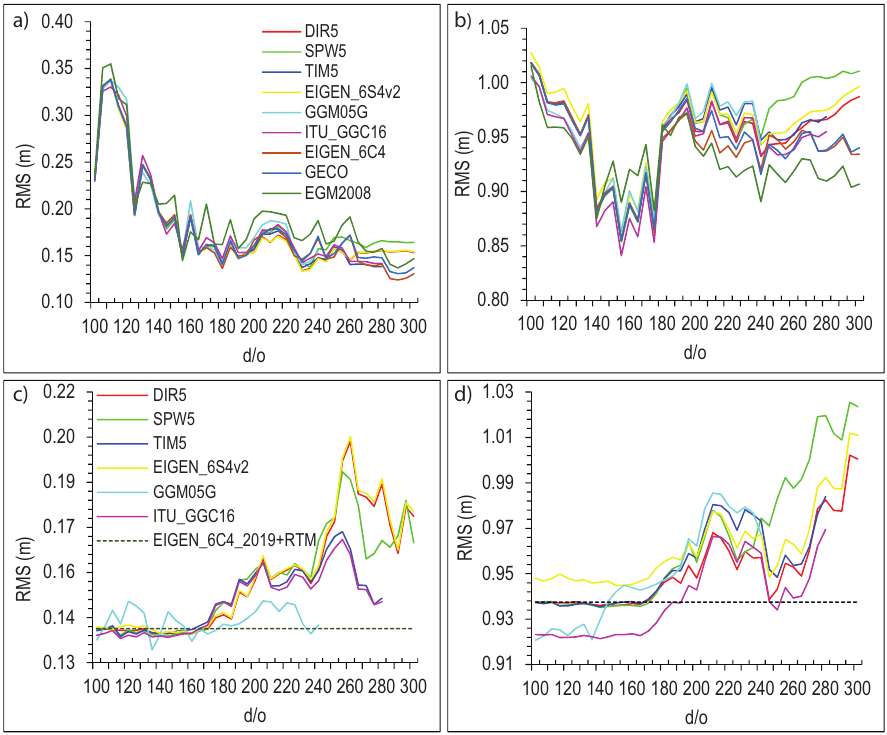
Figure 6. RMS of geoid height as function of d/o of spherical harmonics before SEM: a – in Niger; b – in Northern Nigeria; and after SEM: c – Niger; d – in Northern Nigeria